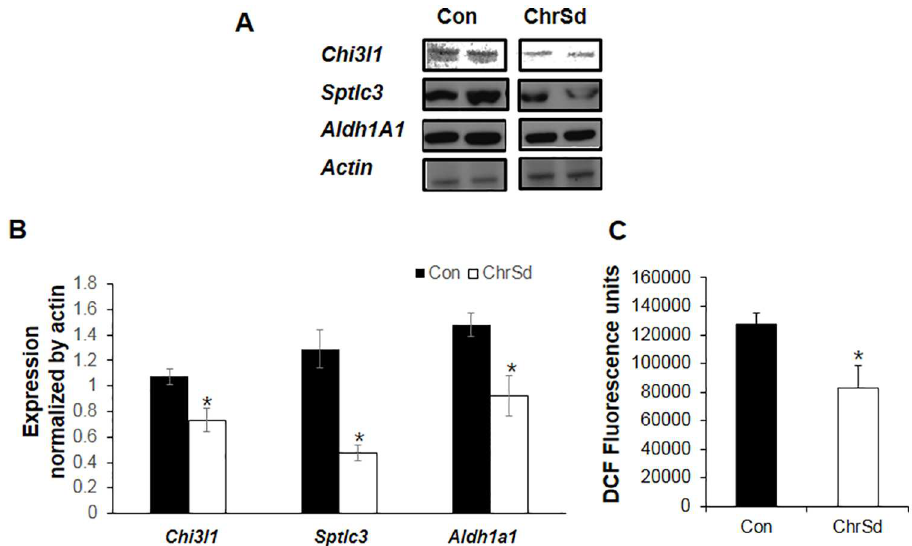
inducedobese mice (DIO) fed high-fat(HF) diets containing 5% microcrystalline cellulose(MCC, control) or 10% (w/w) ChrSd for 5 weeks. (B) Quantificationof protein expressionin (A). (C) DCF fluorescence intensity in the liver of male DIO mice fed HF diets containing5% MCC or 10% ChrSd for 5 weeks. Data are expressed as mean ± SE; n = 3/group. * P <